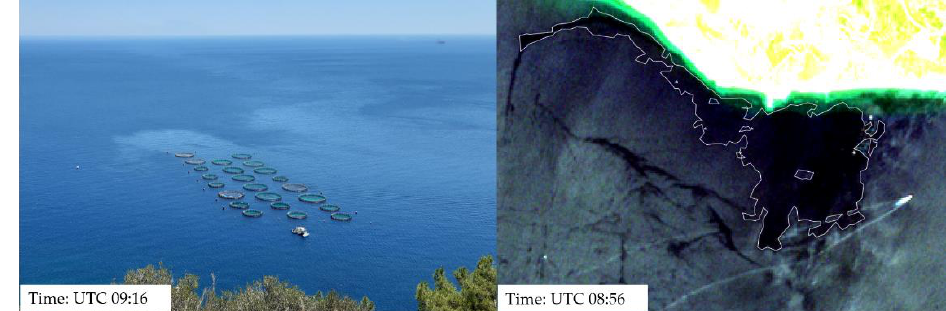
Figure 13. Both images were captured on 26.07.2020. The in situ photo (left) was captured at 09:16 (UTC) and the Sentinel-2 image (right) was captured at 08:56 (UTC).